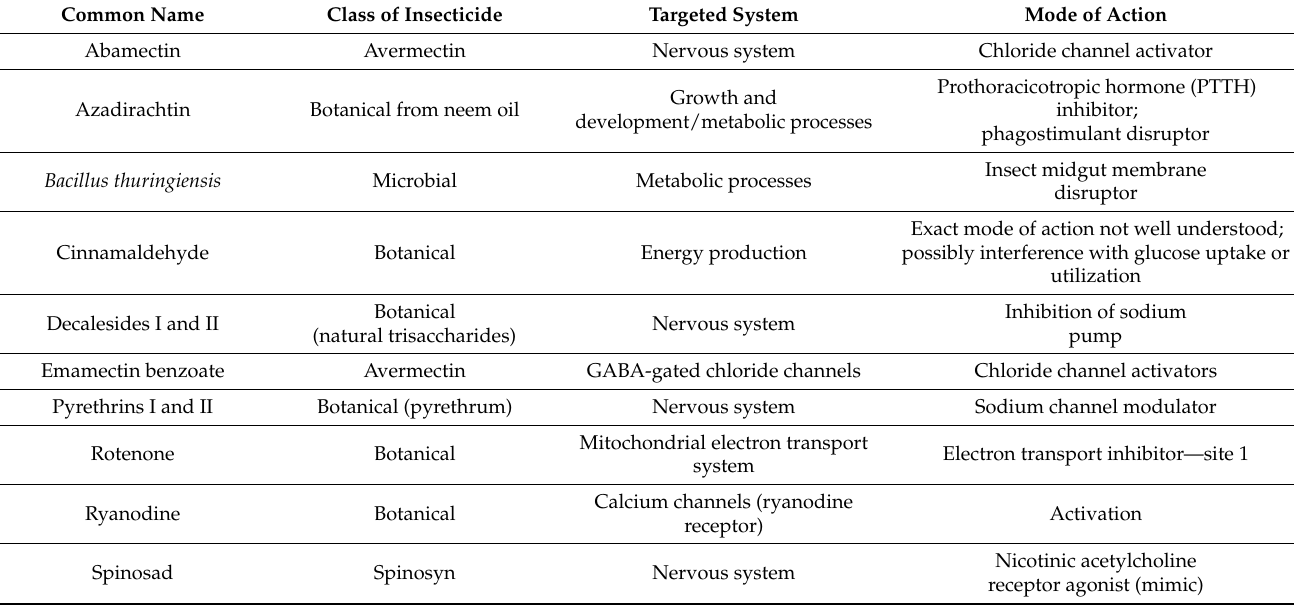
Table 2. Biochemical sites of action of natural insecticides